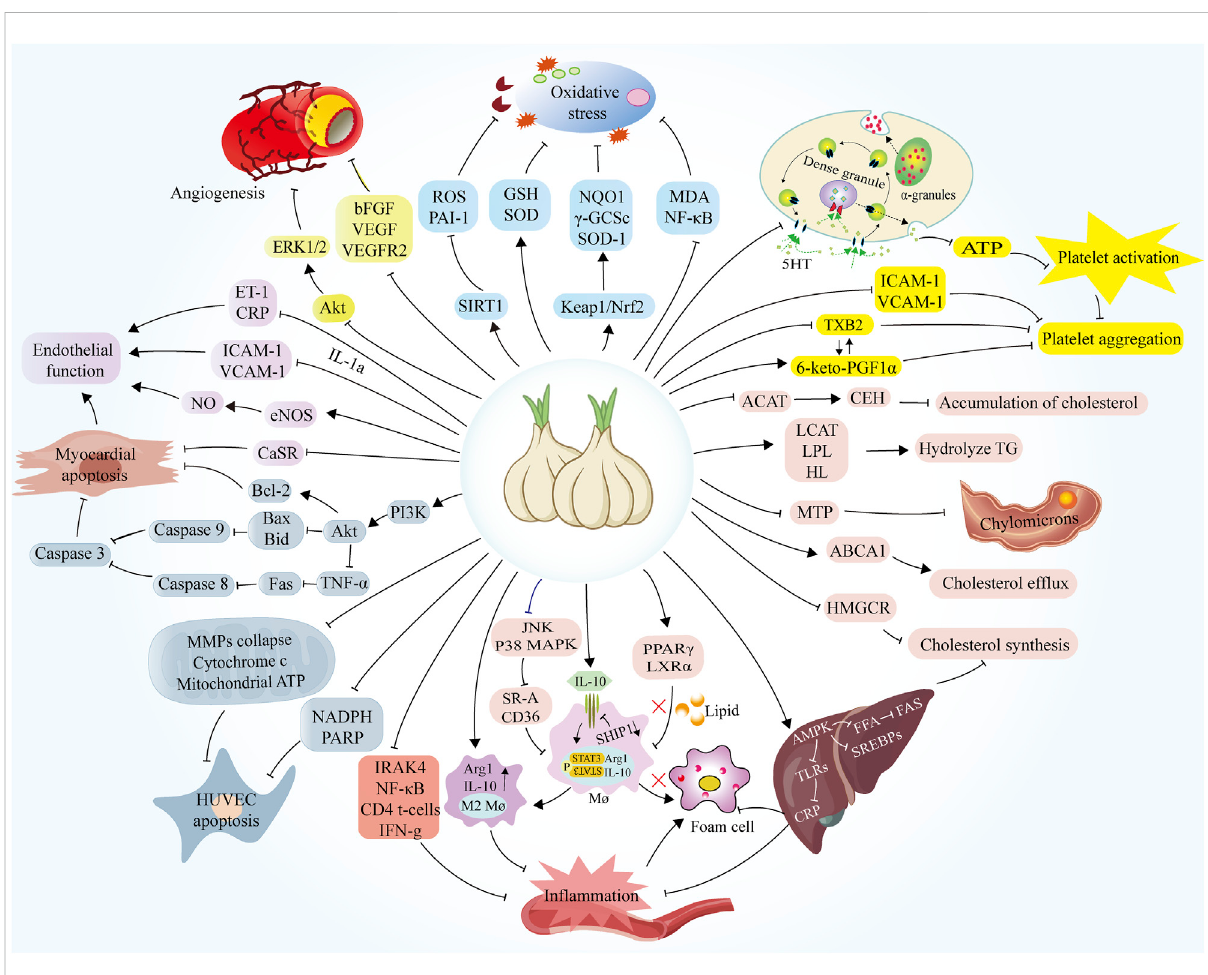
FIGURE 5 Mechanisms of the protective role of garlic in the treatment of atherosclerosis. ACAT, cholesterol acyltransferase; CEH, Cholesteryl ester hydrolase; LCAT, Lecithin cholesterol acyltransferase; LPL, Lipoprotein lipase; HL, Hepatic lipase; MTP, Microsomal triglyceride transfer protein; ABCA1, ATP Binding Cassette Subfamily A Member 1; HMGCR, Hydroxy-3-methyl glutaryl coenzyme A reductase; AMPK, AMP-activated protein kinase; FAS, Fatty acid synthase; SREBP, Sterol regulatory element-binding protein; TLR, Toll-like receptors; CRP, C-reaction protein; PPAR γ , Peroxisome proliferator-activated receptor Gamma; LXR α , Liver X receptor α ; IL-10, Interleukin-10; SHIP1, Src homology-2-containing inositol 5 ′ - phosphatase 1; STAT3, Signal transducer and activator of transcription 3; Arg1, Arginase1; IRAK4, Interleukin-1 receptor-activated kinase 4; NF- κ B, Nuclear factor kappa-B; IFN-g, Interferon gamma; NADPH, Nicotinamide adenine dinucleotide phosphate; PARP, Poly adenosine diphosphate- ribose polymerase; MMPs, Matrix metalloproteinases; TNF- α , Tumor necrosis factor- α ; Fas, Fatty acid synthase; Bax, BCL2-Associated X; Bid, RecombinantHuman BH3-Interacting DomainDeath Agonist;Bcl-2,B-cell lymphoma-2;CaSR,Calcium-sensingreceptor;eNOS, Endothelinnitric oxide synthase; ICAM-1, Intercellular cell adhesion molecule-1; VCAM-1, Vascular Cell Adhesion Molecule 1; ERK1/2, Extracellular regulated protein kinases; bFGF, Basic fi broblast growth factor; VEGF, Vascular endothelial growth factor; SIRT1, Sirtuin 1; ROS, Reactive oxygen species; PAI-1, Plasminogen Activator Inhibitor-1; GSH, Glutathione; SOD, Superoxide Dismutase; NQO1, NAD(P)H:quinone oxidoreductase 1; γ -GCSc, γ -glutamylcysteine synthetase antibody; SOD-1, Superoxide Dismutase 1; MDA, Malondialdehyde; TXB2, Thromboxane